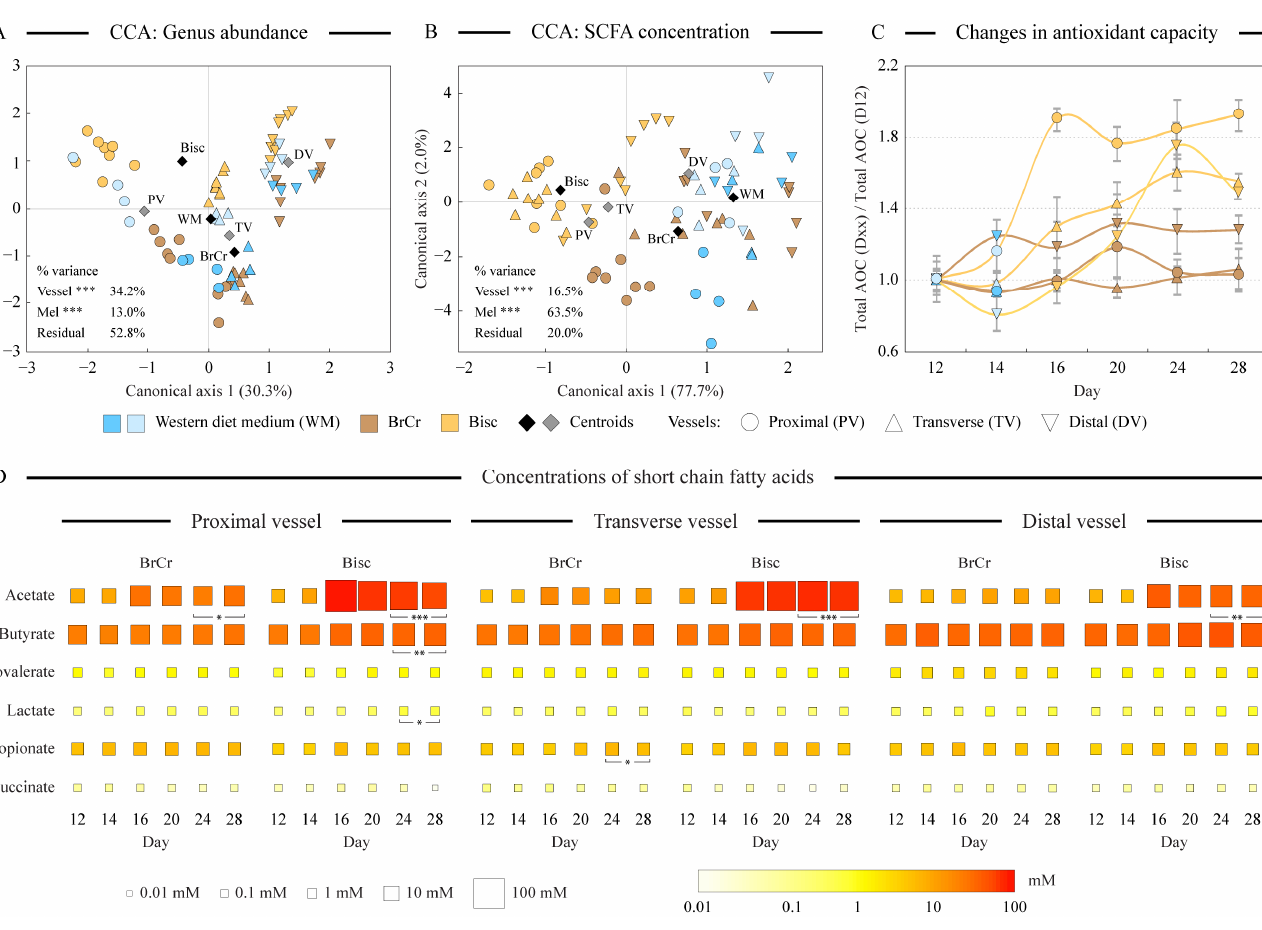
Figure 2. Analysis of community composition and metabolite production. Panels ( A , B ) display the output of the constrained canonical correspondence analysis (CCA) of the genus abundance (panel ( A )) and short-chain fatty acid concentration (panel ( B )) datasets. Medium type and vessel identity were used as explanatory variables that constrained the variability of each dataset. The percent of dataset variability explained by each axis is shown in parentheses in axis titles. For constraining categorical variables, the position of each class centroid is indicated with a diamond. The analysis of variance of the CCA outputs revealed the relative contribution of explanatory variables to the overall variability in the dataset; ***: p < 0.001. Panel ( C ) displays the change in the antioxidant capacity of An evaluation version of novaPDF was used to create this PDF file. cultures over time, defined as the ratio of total antioxidant capacity (AOC) in that sample divided by the total AOC from day 12 sample of the corresponding run. Error bars represent the standard error of the mean calculated for each ratio. Panel ( D ) visualizes the concentrations of measured short-chain fatty acids in all samples using color and size gradients as shown. Each square represents an average value between two replicate runs. Brackets denote cases where a statistically significant difference was calculated between the day 24 and day 28 values of a SCFA in comparison with day 12 and day 14 values. Significance levels: *: p < 0.050; **: p < 0.010; ***: p <